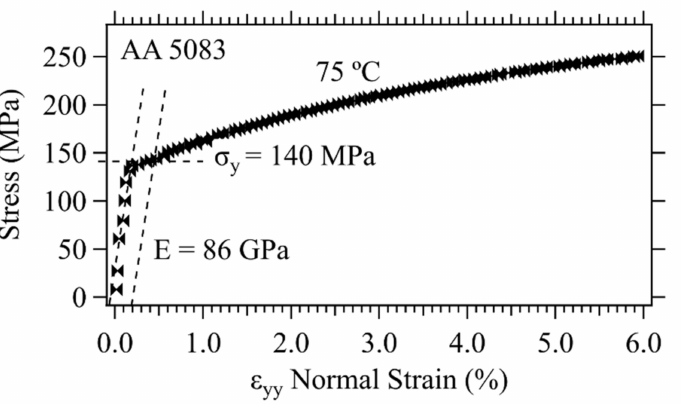
Figure 6. Stress–strain curves 75 ◦ C. The elastic modulus, E, was calculated using the slope of the elastic region and the yield strengths using the 0.2%